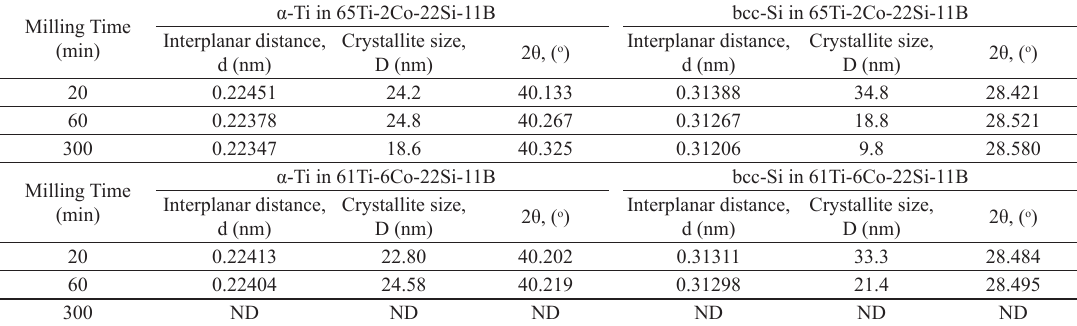
Table 3. Interplanar distance (d), crystallite size (D), diffraction angle (2θ) of major α-Ti and bcc-Si peaks in 65Ti-2Co-22Si-11B and 61Ti-6Co-22Si-11B powders milled at different times, which were determined by Rietveld refining. Milling Time (min)